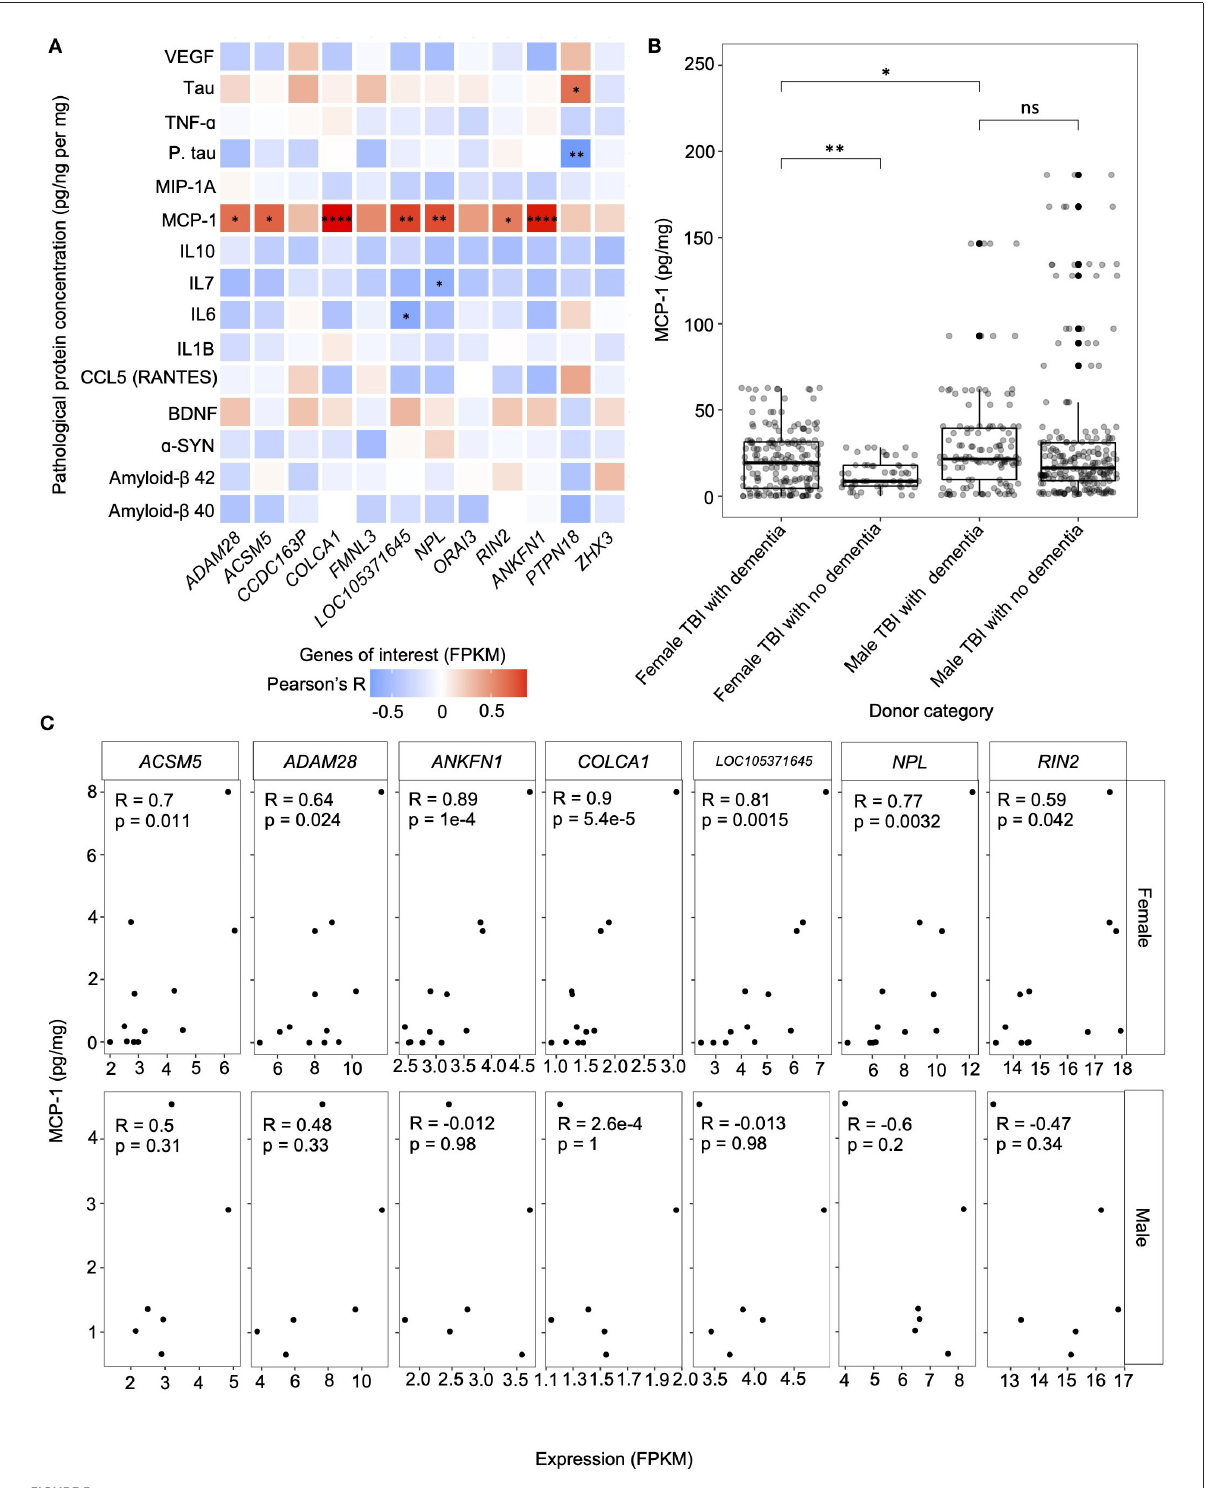
FIGURE5 Correlation between the expression of the genes of interest and protein concentrations. (A) Gene-protein correlation computed using Pearson’s method between the genes of interest — including primary hub genes ( ANKFN1 , PRPN18 , and ZHX3 ) and genes that were amongst the top 20 contributors to PC1 in both principal component analyses (PCAs); comparing the expression levels of all candidate module genes in the